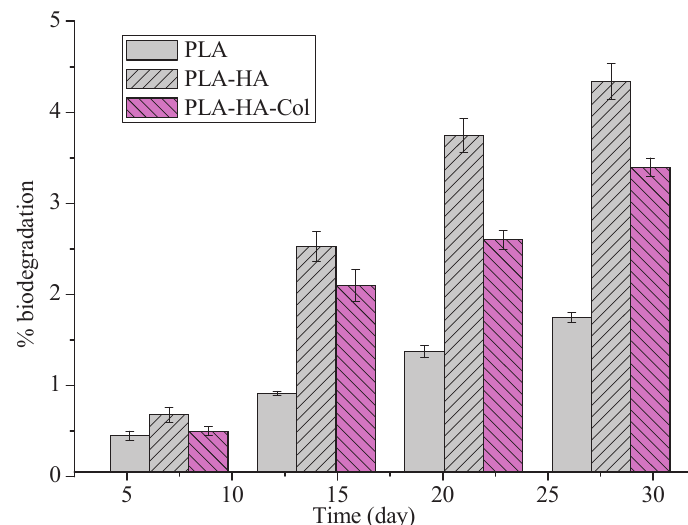
Figure 10: Degradation of scaffold in PBS solution.